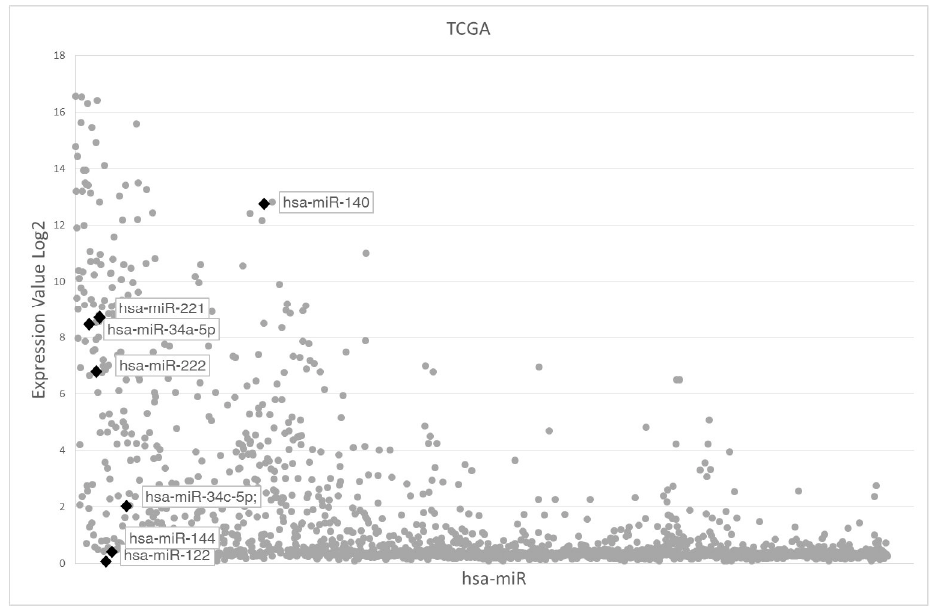
Figure 1. Scatter plot of miR expression in the uveal melanoma (UM) The Cancer Genome Atlas data portal (TCGA) dataset. x -axis: miRs (1938) present in the TCGA; y -axis: mean expression value of each miR in the 78 patients. MiR122 and miR144 are present at the bottom level of expression within all miRs. The expression of other miRs which target either ADAM10 or c-Met is indicated for comparison. The expression levels of miR221 and miR222 are also indicated as positive control of miRs expression. The expression value is calculated as the base 2 logarithm of fluorescence intensity of each miR.